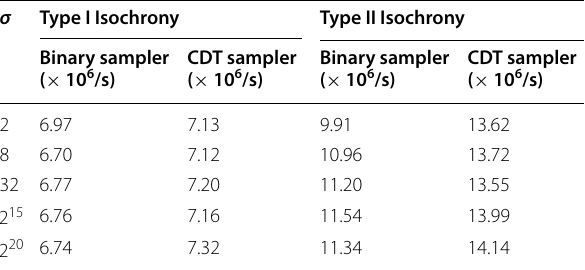
Table 6 Number of samples per second at 3.6 GHz for our new Gaussian sampler Algorithm 4